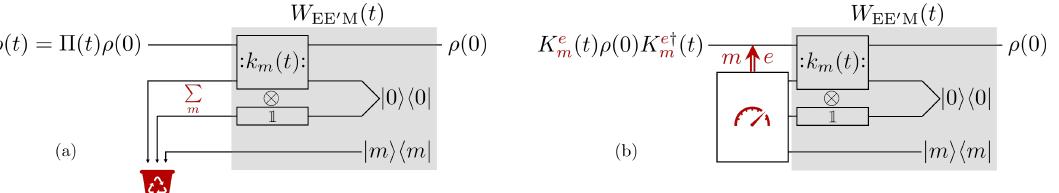
Figure 3: Quantum circuits corresponding to the refined operator-sum (14) and its terms. The auxiliary meter M keeps track of which modes m of the environment have interacted with the system. (a) Reduced evolution: Neither the outcomes of possible measurements on the purified environment, e , nor those on the auxiliary meter, m , are communicated. (b) Conditioned evolution: The list of modes m that have interacted with the system and the measured states | e 〉 are